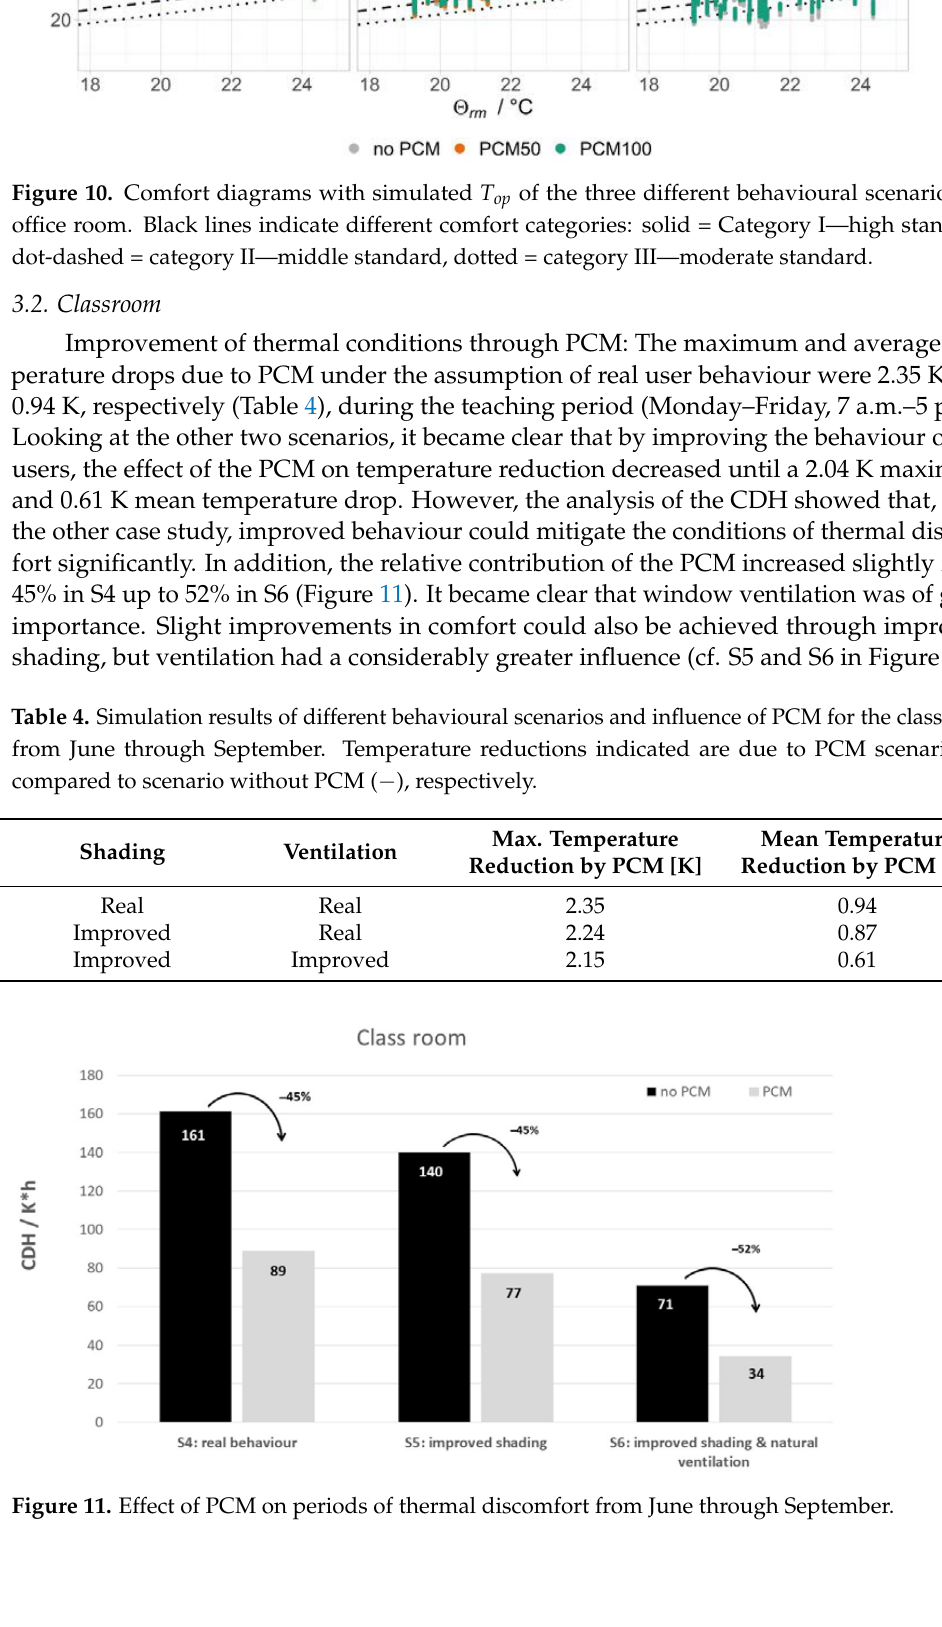
Figure 12. Comfort diagrams with simulated T op of the three different behavioural scenarios for classroom. Black lines indicate different comfort categories: solid = Category I—high standard, dot- dashed = category II—middle standard, dotted = category III—moderate standard. 4. Discussion 4.1. Impact of PCM Our simulation results revealed that the PCM still worked after more than a decade in operation and still had a positive impact on the thermal behaviour of the rooms. The analyses indicated that in both cases there was a decrease in the PCM capacity in the meantime in the range of up to 50%. Moreover, all the behavioural scenarios showed a temperature-reducing effect through the PCM during working hours. In the office room it was on average 0.2–0.4 K, and in the classroom, it reached 0.6–0.9 K, which was some- what higher. Temperature peaks could also be significantly mitigated by the PCM. In the office, maximum temperature reductions of between 0.7–1.2 K and in the classroom of 2.0–2.4 K could be achieved, depending on the scenario. When measuring the discomfort time, it became clear that the PCM was able to reduce the uncomfortably warm time in the office room by 9 to 34%, whereas its effect in the classroom was considerably higher at a 45 to 52% reduction. However, in both buildings, the PCM was able to contribute to an improvement in thermal comfort in all scenarios. The greater influence of the PCM in the classroom can be attributed to two factors: the construction of the buildings and the prevailing temperature level. While the office in the Sonnenschiff has a massive construction with thermally heavy ceilings and floors, the T o p / ° C